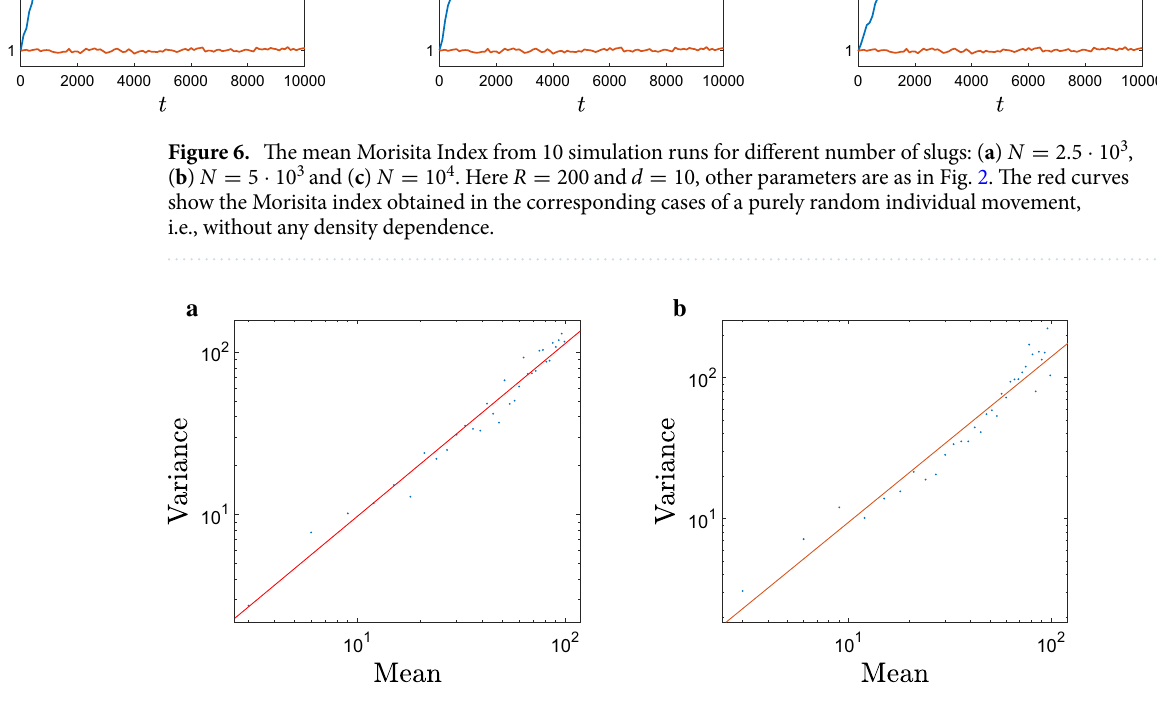
Figure 7. The variance of bin populations plotted against the mean bin population on a grid of 100 bins shown on a log-log scale. Each point is calculated from a single simulation and the total population is 300 to N 9900 in intervals of 300. The density dependent parameters varied between simulations from N = = 1 (equal to the average slug density) and R 1000 , the regression equation (10) is 2 . ( a ) t are d = = = log ( v ) 1.066 log ( m ) 0.1774 , r 2 1.173 log ( m ) 0.4551 , r 2 0.9686 , ( b ) t 10, 000 , log ( v ) 0.9427 = − = − = = =